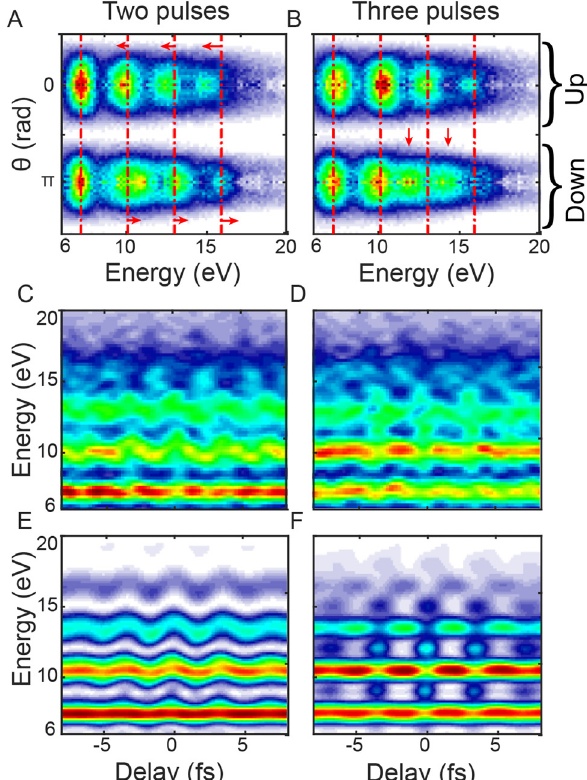
Figure 7: Two-color photoionization of helium. (A, B) Angular-resolved spectrograms. Red dashed lines mark the positionofabsorptionpeakscorrespondingtooddharmonicsinthe extreme ultraviolet (XUV) only case. (C, D) Experimental and (E, F) simulated extreme ultraviolet-infrared (XUV-IR) delay traces, by integrating in the down direction. A, C, and E show the two pulse- case (CEP π /2), and B, D, and F the three pulse case (CEP